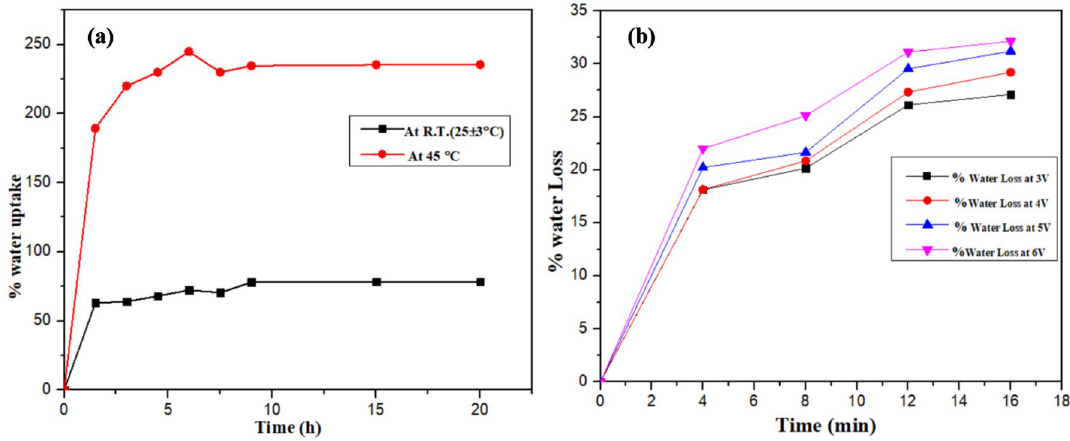
Figure 5. ( a ) Percentage water uptake of the SA/SPVA-PANI membrane and ( b ) percentage water loss of the SA/SPVA-PANI membrane at room temperature.